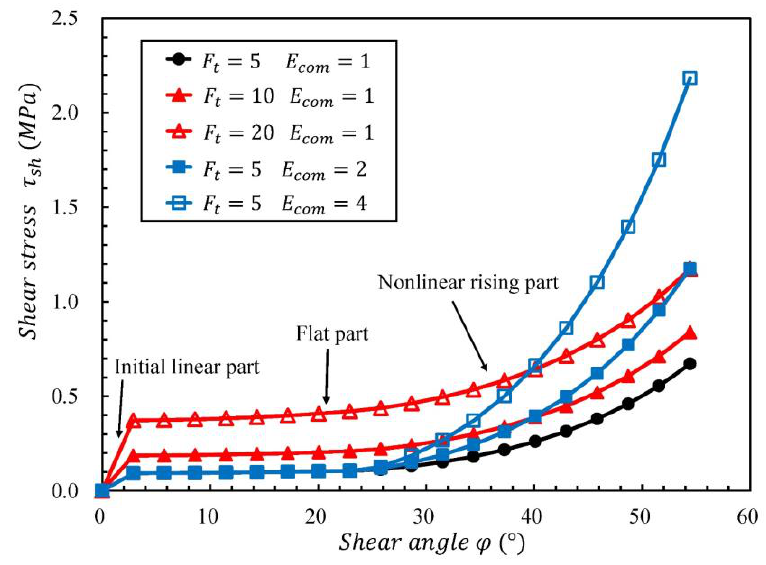
Figure 11. Sensitivity study on the shear behavior of a fabric.